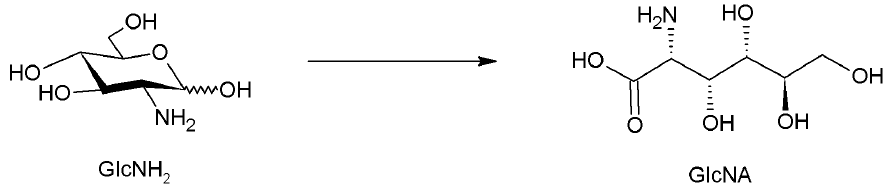
Figure 30. Oxidation of GlcNH 2 to GlcNA.